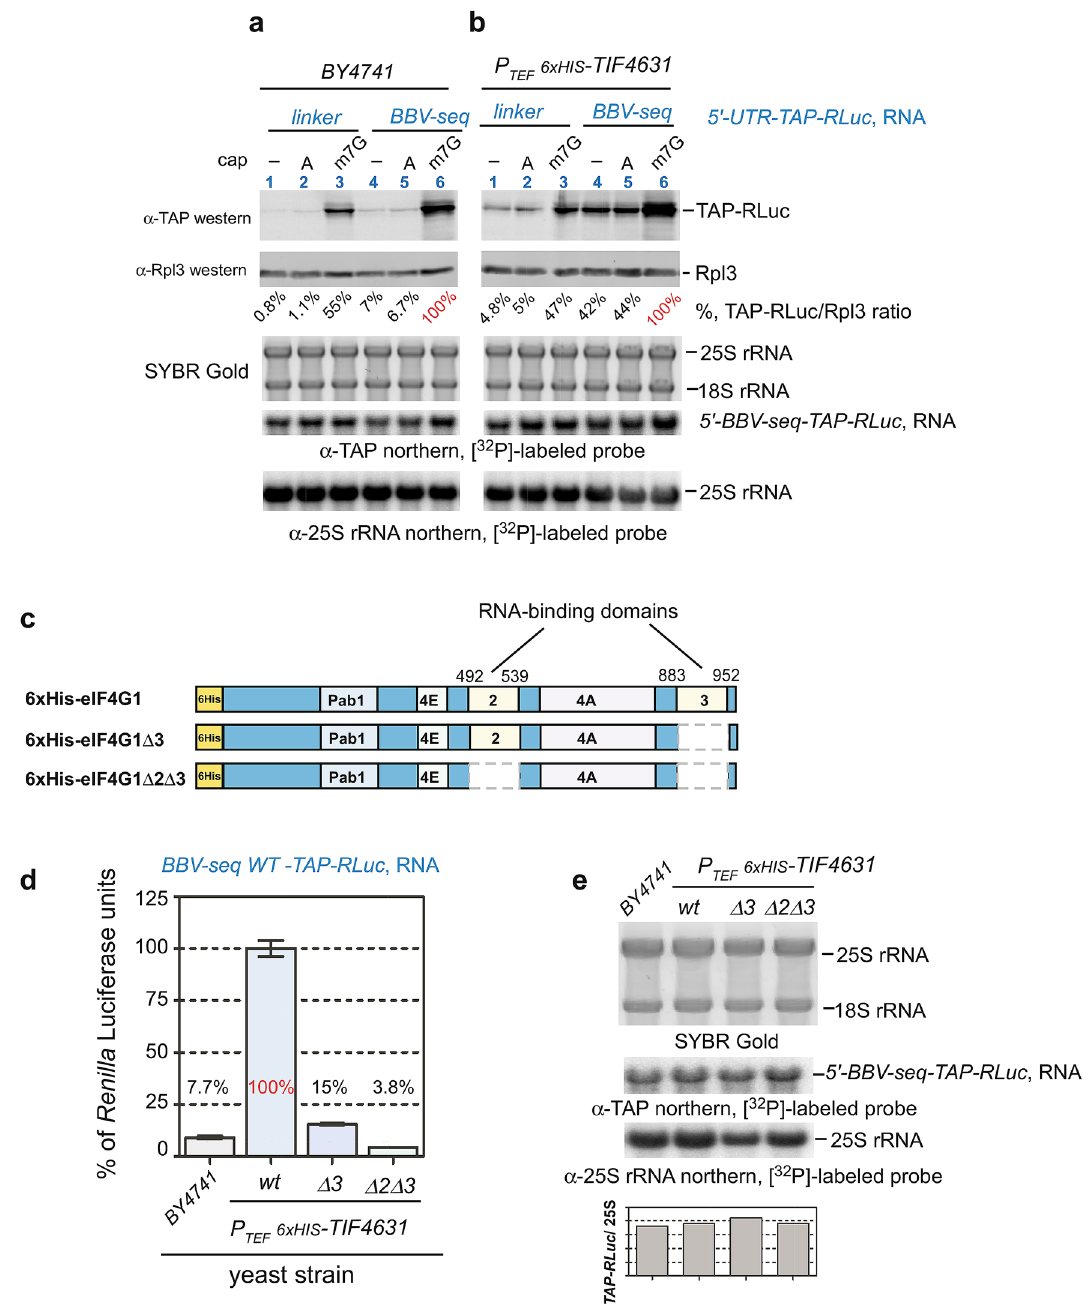
Figure 7. BBV-seq-mediated translation depends on RNA-binding domains of eIF4G1. ( a , b ) Linker- or BBV-seq-containing mRNAs were capped in vitro with m7G-cap (m7G), ApppG-cap (A), or remained uncapped (−), and were translated in yeast lysates prepared from the wild-type BY4741 strain ( a ) or from the P TEF -6 × HIS-TIF4631 strain, which overexpresses eIF4G1 ( b ). Translation products were analyzed by quantitative western blotting as described in “Methods” section (top). Quantification and normalization of TAP- RLuc are shown in Supplementary Fig. S5; TAP-RLuc amount in the reaction charged with m7G-capped BBV-seq-TAP-RLuc RNA was set as 100% (shown in red) to calculate the relative % of the reporter produced in each reaction. RNA was extracted from the same translation reactions, resolved on agarose gel under denaturing conditions, and stained with SYBR Gold prior to transfer, followed by northern hybridizations with the indicated probes (bottom). ( c ) Schematic representation of major domains in yeast eIF4G1. Pab1 indicates the poly(A)-binding protein domain, 4E is the eIF4E-binding domain, 4A is the eIF4A-binding domain, the RNA- binding domains are also shown. A 6× His tag was placed at the N-terminus of eIF4G1 (marked in yellow). 6× His-eIF4G1 indicates full-length protein; 6× His-eIF4G1Δ3 and 6× His-eIF4G1Δ2Δ3 designate proteins with RNA-binding domain 3 or 2/3 deletions. Numbering on the top indicates amino acid positions in eIF4G1. ( d ) Translationally competent yeast lysates indicated on the figure were programmed with BBV-seq-TAP-RLuc mRNA. Protein translation was assessed using Renilla luciferase assays and is presented as bar graphs. Data are represented as % Renilla Luciferase units derived from the reactions performed with lysate from P TEF -6 × HIS- TIF4631 cells programmed with BBV-seq-WT-TAP-RLuc mRNA. Error bars represent standard error of the mean (SEM) of three individual experiments. ( e ) RNA was extracted from luciferase reactions in ( d ) and analyzed by SYBR Gold staining, followed by northern hybridizations with the indicated probes. The TAP-RLuc /25S rRNA ratio for each reaction is shown as a bar